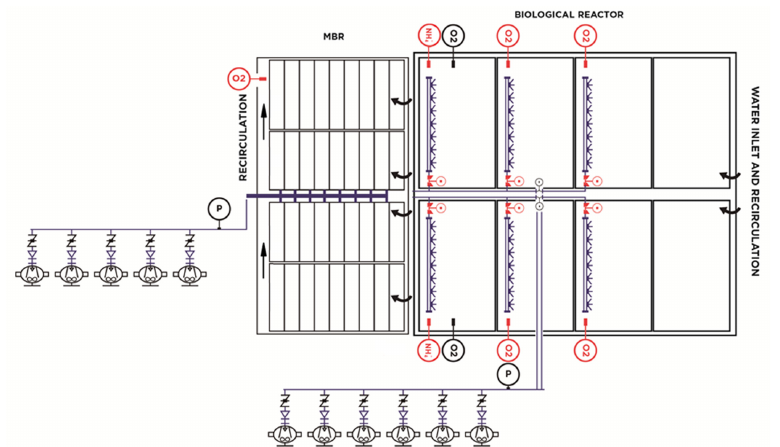
Figure 5. New aeration operation scheme.